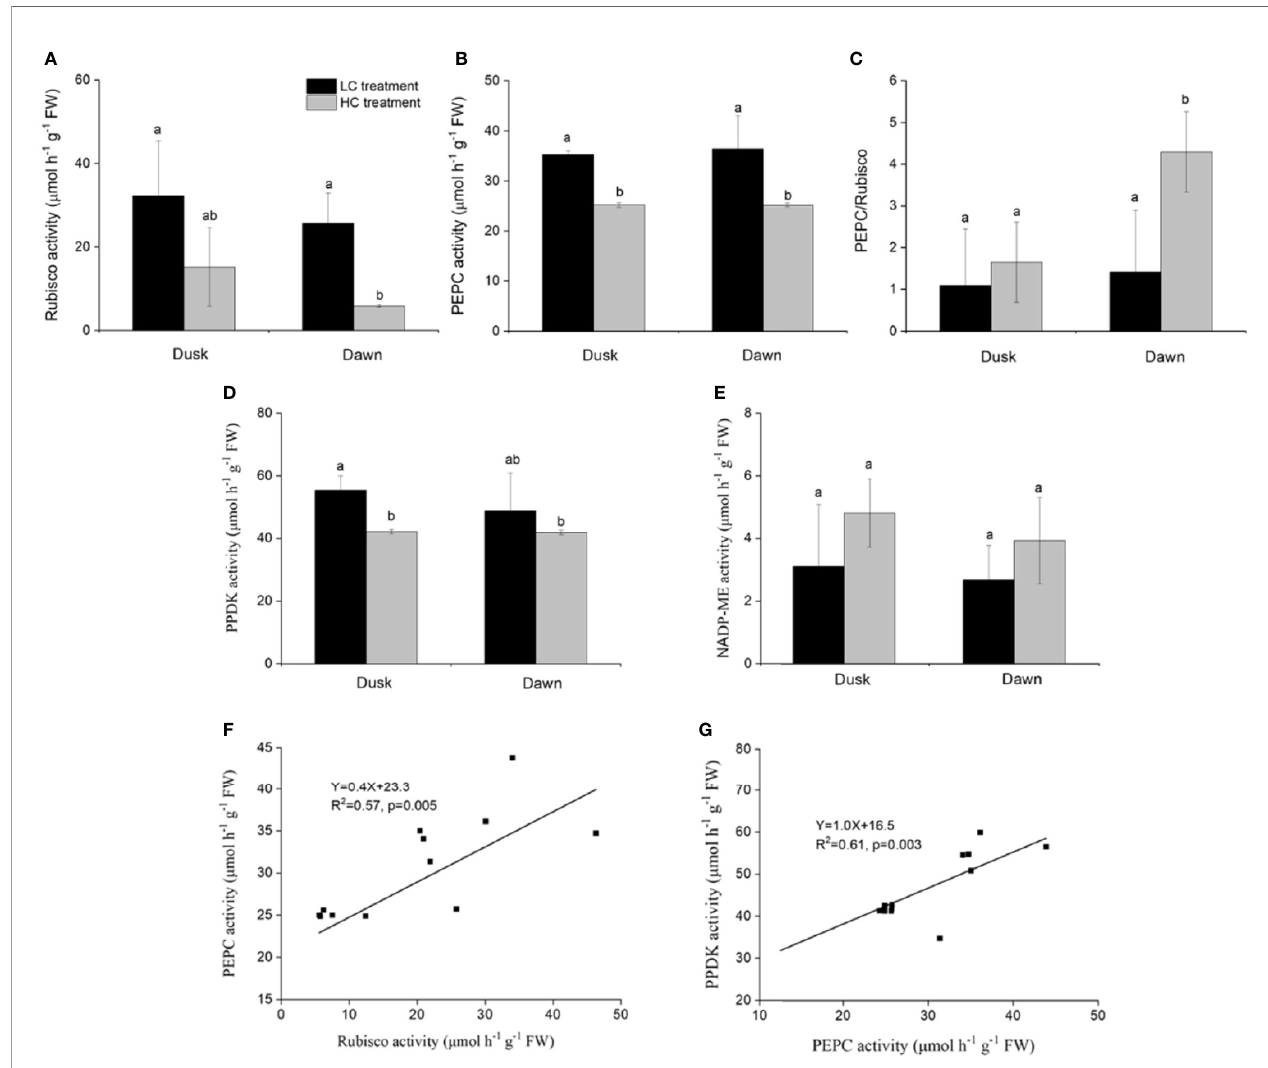
FIGURE 2 | In fl uence of CO 2 concentrations on activities of enzymes from O. cordata fl oating leaves collected at dusk (21:00 h, before the lights turn off) and dawn (07:00 h, before the lights turn on), as well as the correlations between activity of Rubisco, pyruvate phosphate dikinase (PPDK) and activity of phosphoenolpyruvate carboxylase (PEPC) at dusk and dawn, grown at low and high concentrations of CO 2 . (A) Rubisco activity. (B) PEPC activity. (C) Ratio of PEPC to Rubisco activity. (D) PPDK activity. (E) NADP-malic enzyme (NADP-ME) activity. (F) Correlation between activity of Rubisco and activity of PEPC. (G) Correlation between activity of PPDK and activity of PEPC. In (A~E), the mean values (n=3~4) with their s.d. are shown. Different letters show signi fi cant differences ( p <0.05, post hoc Duncan ’ s test) among treatments. In (F~G), each point represents the activity measured from an individual sample from high CO 2 and low CO 2 acclimated plants. Pearson correlation was used to test the correlation between activity of PEPC and Rubisco, PPDK and